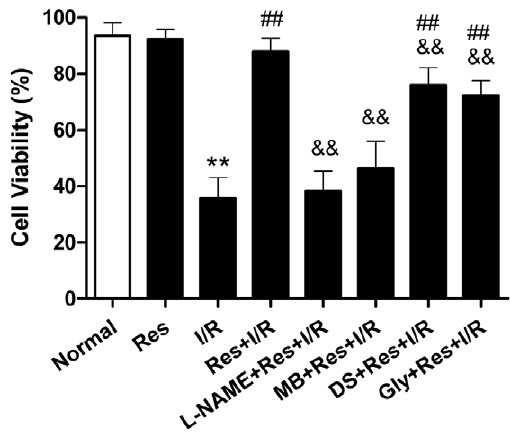
Figure 6. Effect of L-NAME, MB, DS and Gly on the LDH activity in Res + I/R group. The LDH activity in normal group was 658.1 6 97.2, while that in I/R group was 2517.9 6 124.5 and in Res + I/R group 758.8 6 54.6, which had a significant difference compared with I/R group. The effect of Res on the LDH activity was abolished by L-NAME and MB, and was significantly attenuated by DS and Gly. L-NAME, a nitric oxide synthase inhibitor; MB, Methylene blue, a cGMP inhibitor; DS, D-Sphingosine, a PKC inhibitor; Gly, Glibenclamide, a K ATP blocker. ** P , 0.01 versus the normal group. ## P , 0.05 versus the I/R group. && P , 0.05 versus the Res + I/R group. Values are the means 6 SD, n=10 in each group.